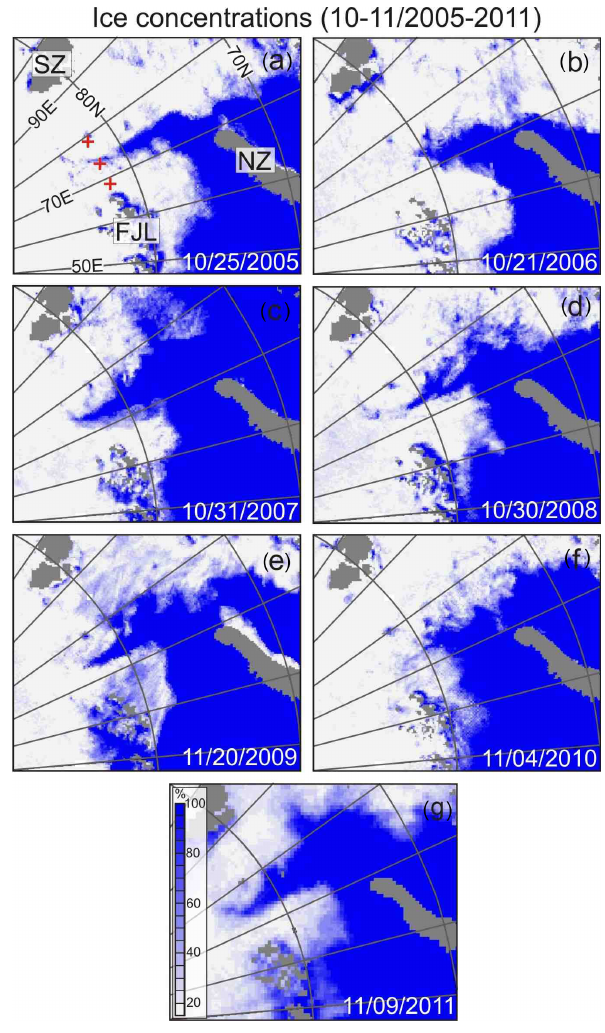
Figure 14. (a – f) The AMSR-E and (g) SSMI sea ice concentrations (%) in October–November 2005–2011. Crosses in (a) depict loca- tions along 81 ◦ N where the June–November time series of sea ice concentration shown in Fig. 12 are